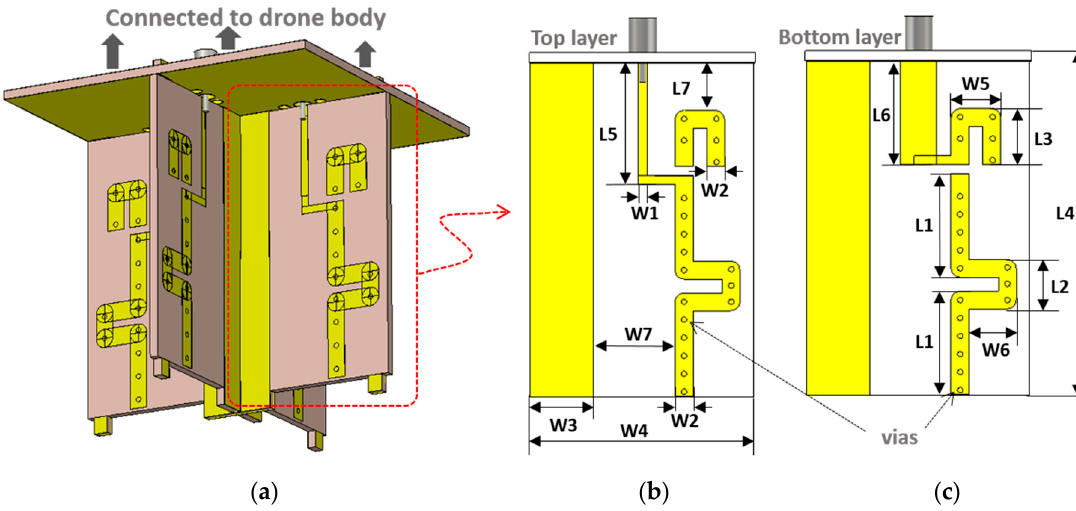
Figure 3. Proposed antenna structure showing ( a ) the complete 1 × 4 array configuration, ( b ) a top layer, and ( c ) a bottom layer of the single antenna element.